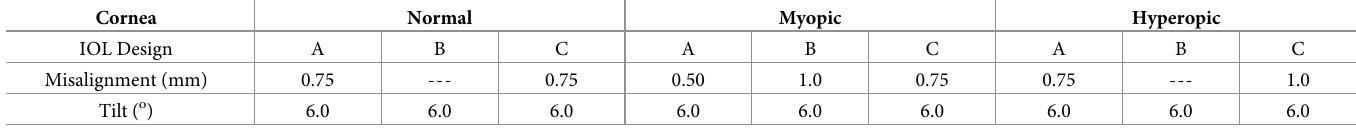
Table 4. Minimum values of misalignment and tilt for which the average of tangential and sagittal MTF is below 0.43 (for an object of 100 cycles/mm and a 3.00 mm pupil diameter) at every analysed cornea.